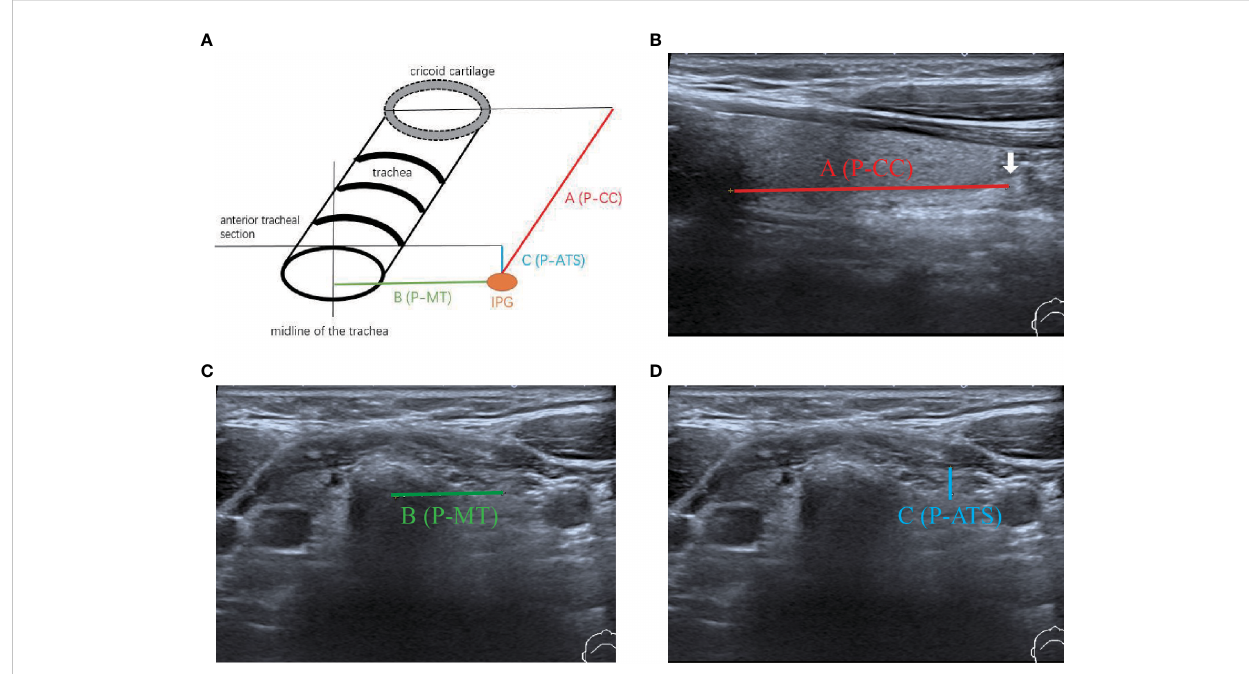
FIGURE 3 Measurement of the relative location of the IPG to the trachea. (A) Diagram of IPG location; (B) The distance of the IPG from the cricoid cartilage (A, PCC); (C) The distance of the IPG from the midline of the trachea (B, P-MT) ; (D) The distance of the IPG from the anterior tracheal section (C, P-